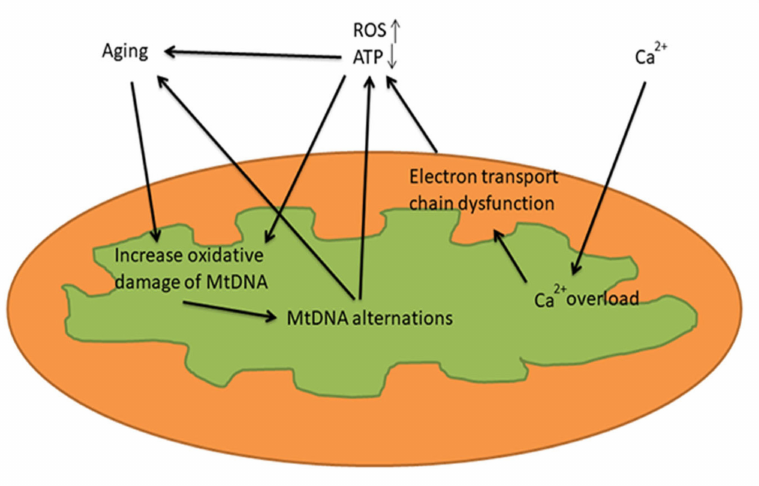
Figure 1. Relationship between aging and mitochondrial dysfunction. Aging can increase the ox- idative damage of MtDNA and MtDNA alternations, leading to mitochondrial dysfunction that increased ROS and reduced ATP. Finally, aging and MtDNA alternations affected each other. A large number of Ca 2+ flowed into mitochondrial, causing mitochondrial Ca 2+ overload, leading to dysfunc- tion of the electron transport chain, which increased ROS and reduced ATP that promoted